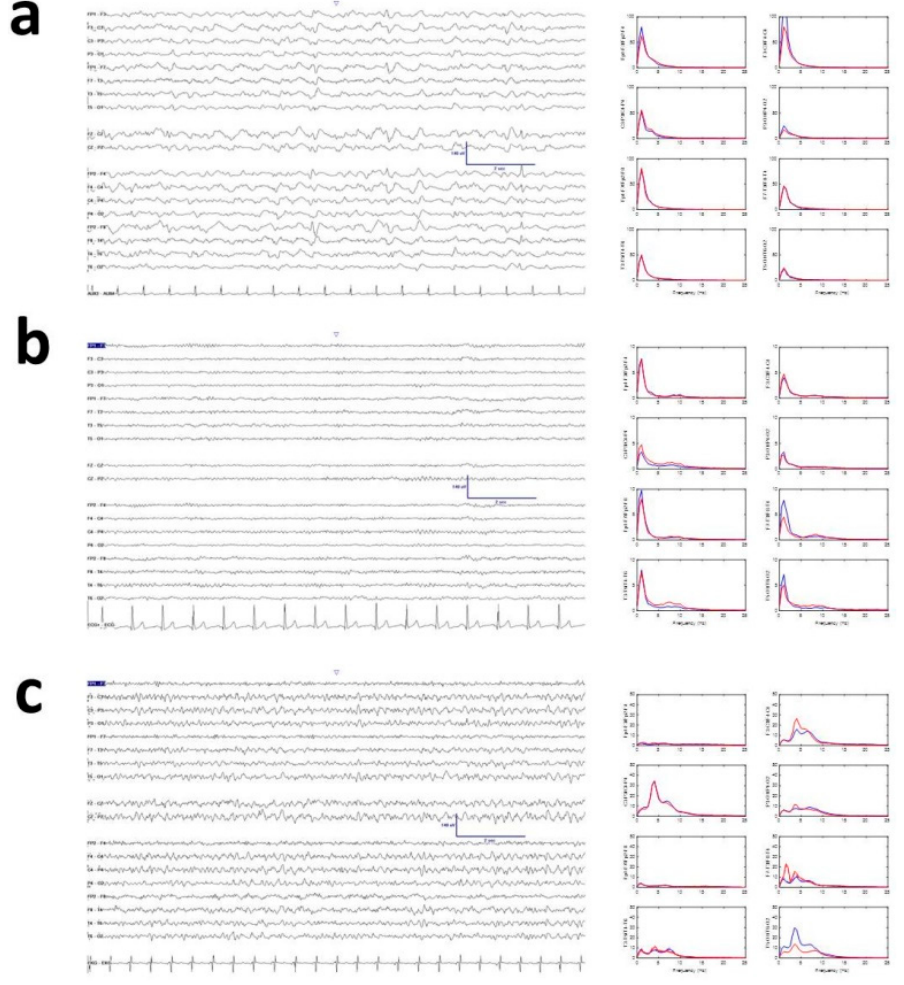
Figure 2. Examples of raw recordings: ( a ) encephalopathy (ENC), ( b ) COVID, and ( c ) cardiorespiratory arrest (CRA). Right column shows mean spectra for channels. Red and blue lines indicate right and left hemispheres, respectively. Y-axis units in µV 2 /Hz.